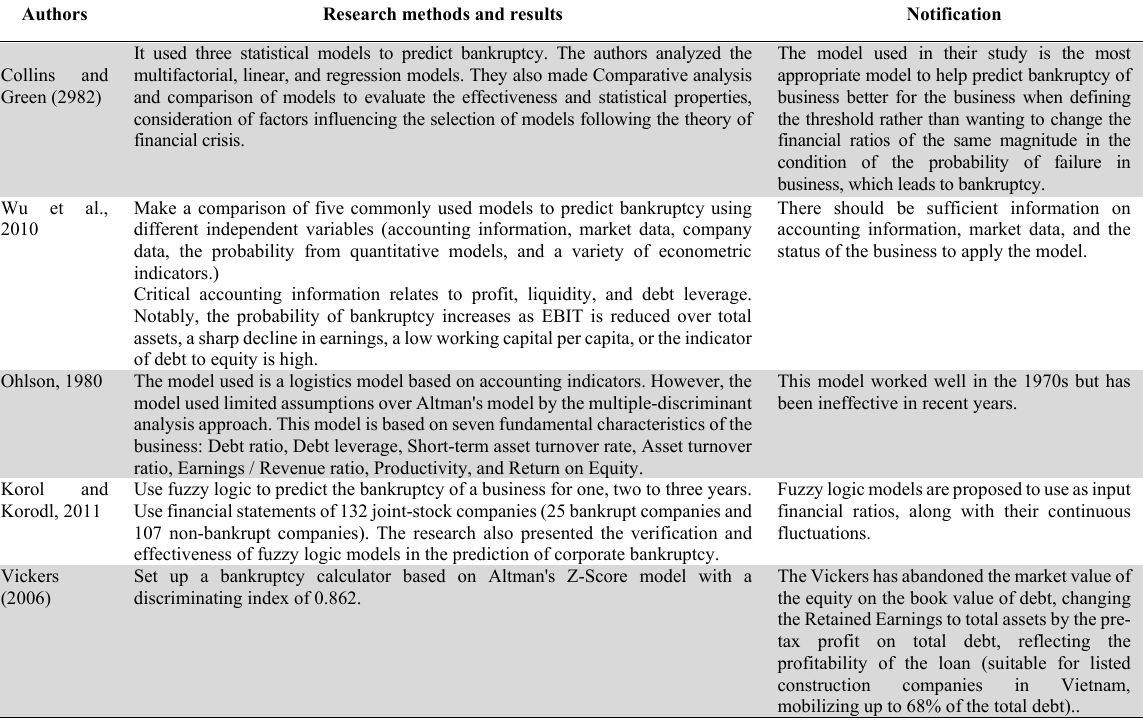
Table 1. Synthesis of variables of models in previous